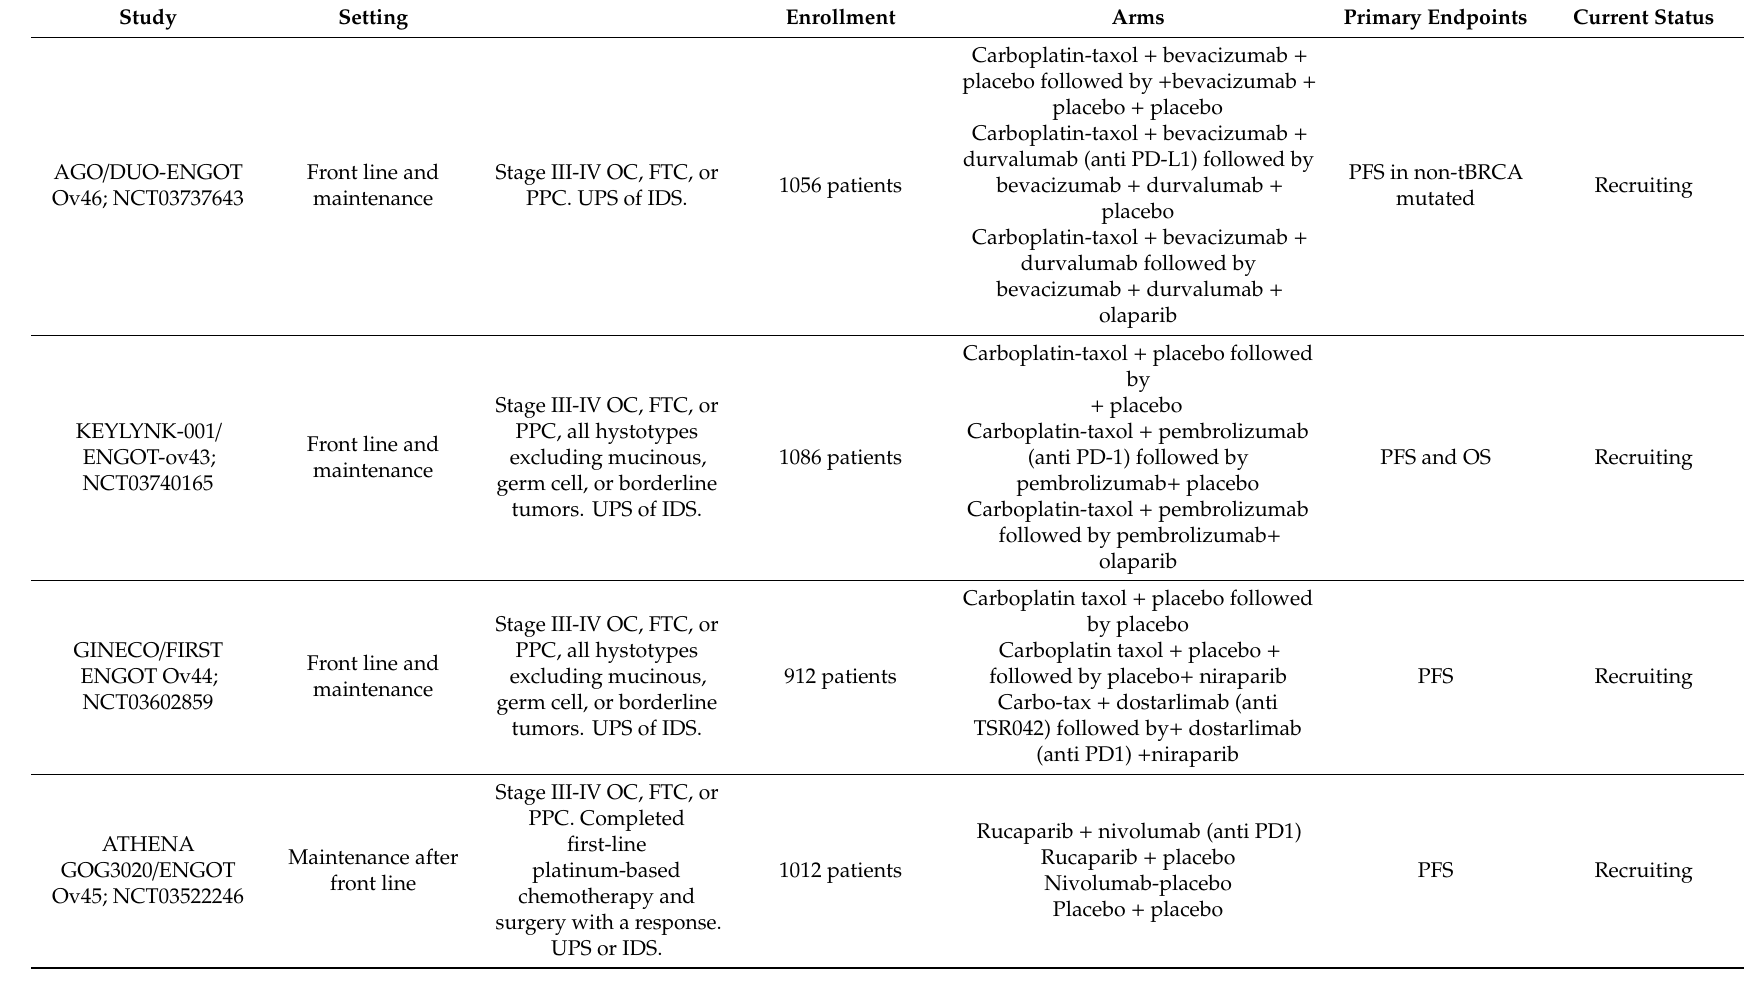
Table 2. Ongoing phase III trials exploring combination of CPIs and PARPIs and / or anti-VEGF